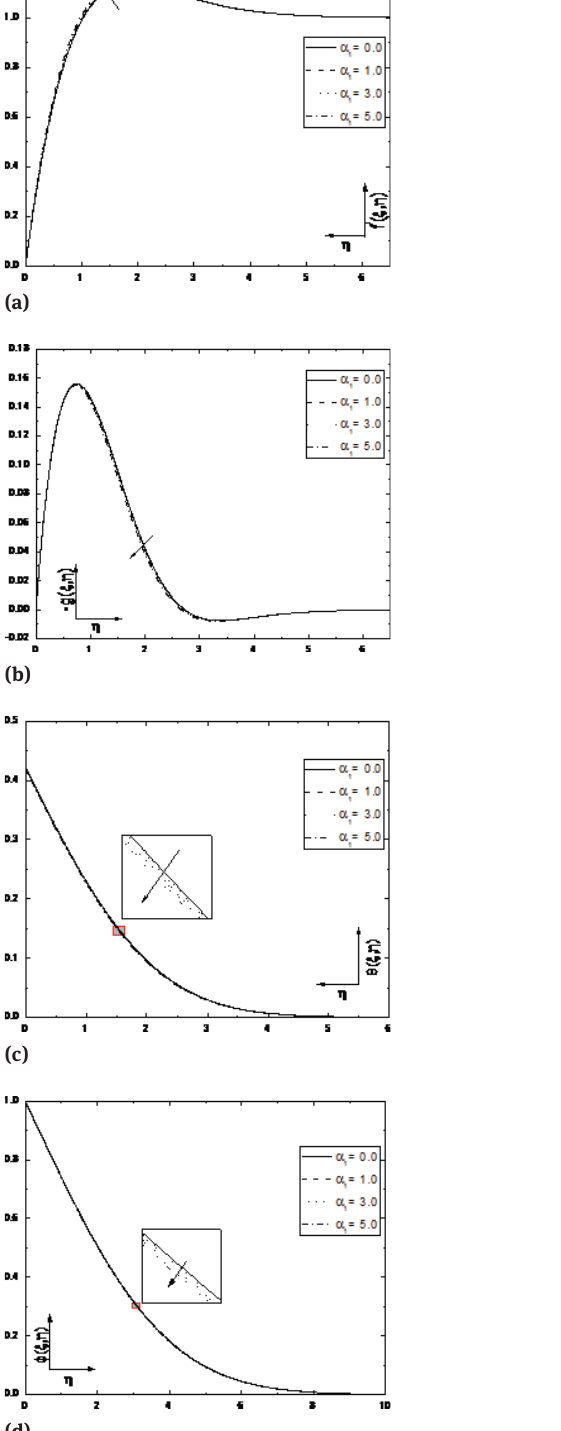
Fig. 2: Effect of nonlinear temperature parameter on the (a) velocity, (b) microrotation, (c) temperature and (d) concentration for Δ = 1.0, Fs = 0.5, α 2 = 5, Ω = π /6, Bi = 0.5, ξ = 0.5 .